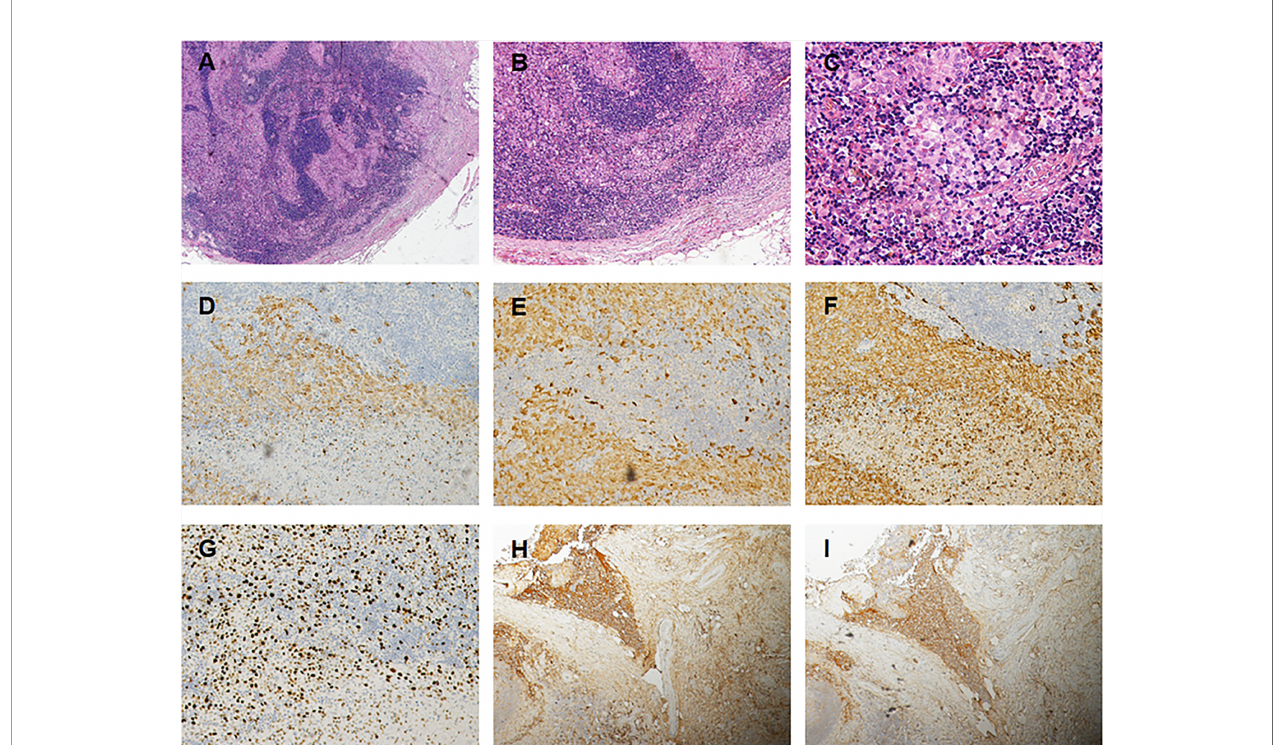
FIGURE 1 | (A) Photomicrograps of a low power image showing an in fl ammatory in fi ltrate composed of Langerhans cells lymphocytes (Hex 4). (B) The clusters of Langerhans cells are accompanied by lymphocytes and an occasional eosinophil (HE x10). (C) The nuclear morphology exhibited by the Langerhan cells, which have relatively uniform was positive to Langerin (D) , S-100 protein (E) and to CD1a (F) , and Ki – 67 (G) antigen markers (x 20). Immunostains for IgH (H) and IgG4 (I) show an IgG4/IgG ratio <40 %, some immune cells were positive and stained, but no positive cells were found in the Langerhans (x